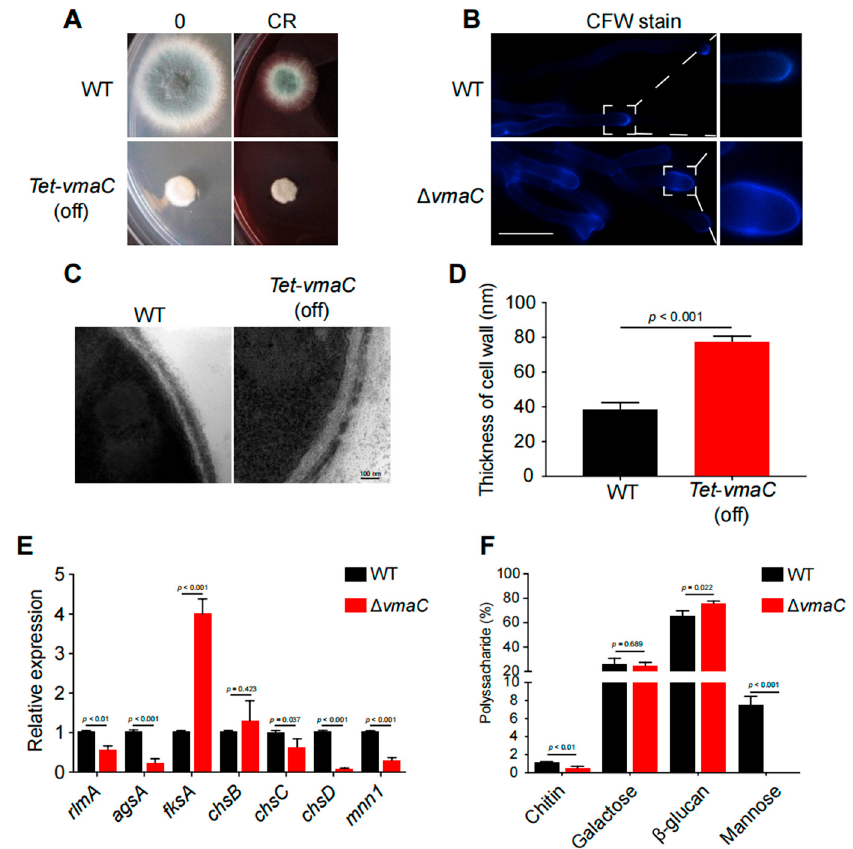
Figure 5. VmaC regulates cell wall architecture and composition. ( A ) The morphology of mycelial pellets of the WT and ∆ vmaC strains cultured on minimal medium supplemented with or without 75 µ g/mL CR. ( B ) Staining of the WT and ∆ vmaC strains for chitin with CFW. Scale bar, 10 µ m. ( C ) Representative TEM images of hyphae of WT and tet - vmaC (off) strains cultured on minimal medium. Scale bar, 100 nm. ( D ) Quantification of the mean cell wall thickness of the WT and tet - vmaC (off) strains as in Panel C. The data are presented as the means and standard deviations of three biological samples, with 10 sections measured for each experimental group. ( E ) Quantitative analysis of the expression of cell-wall-related genes. All the results were obtained in three independent biological experiments (ns, not significant). ( F ) Absolute polysaccharide composition of the mycelial cell walls in WT and tet ‐ vmaC (off) strains. The data are presented as the means and standard deviations of three biological replicates (ns, not significant).